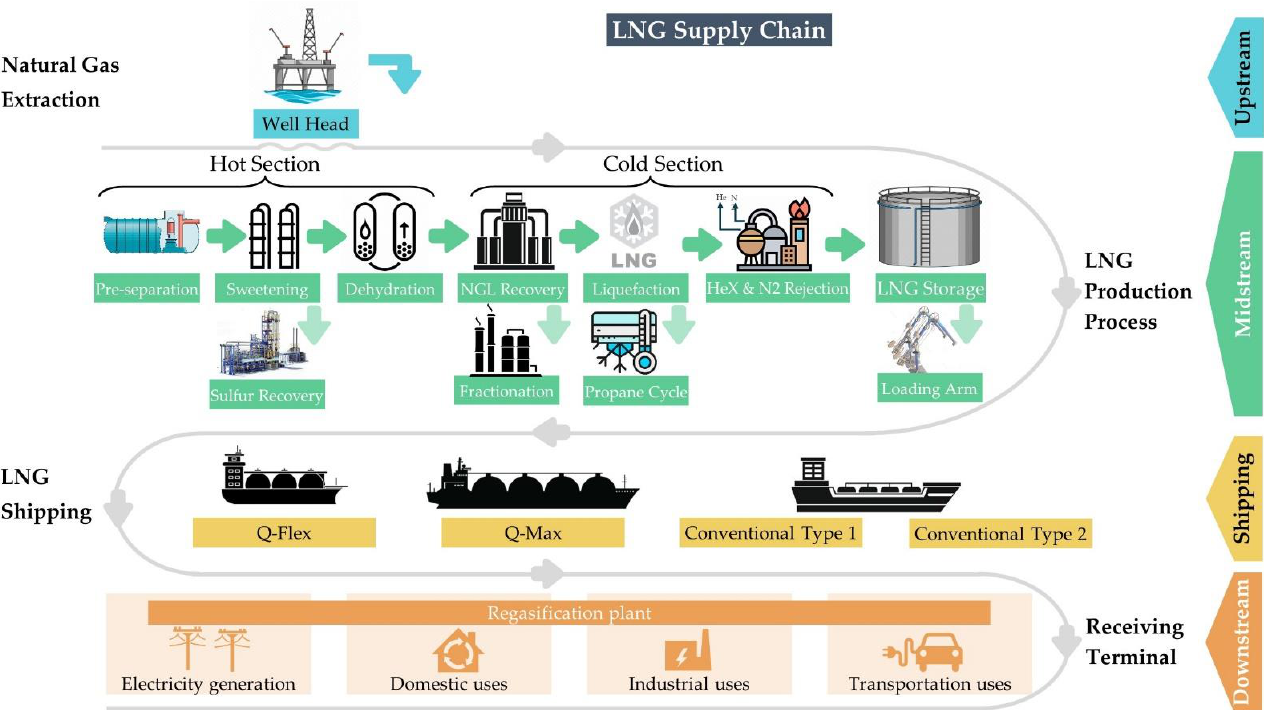
Figure 1. LNG process chain.